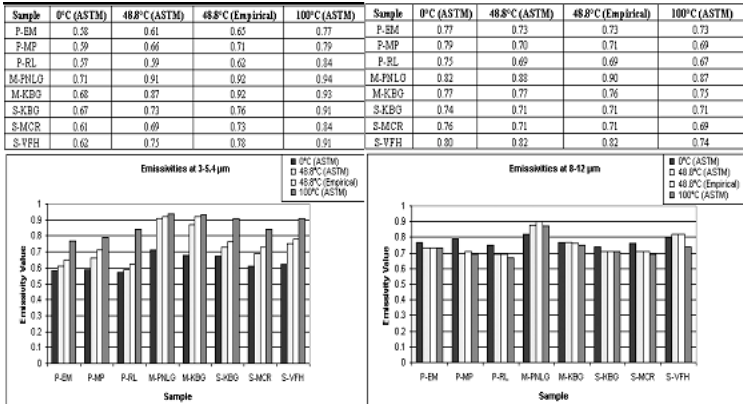
Figure 2. Emissivity values for the 3–5.4 and 8–12 μ m wavelengths.